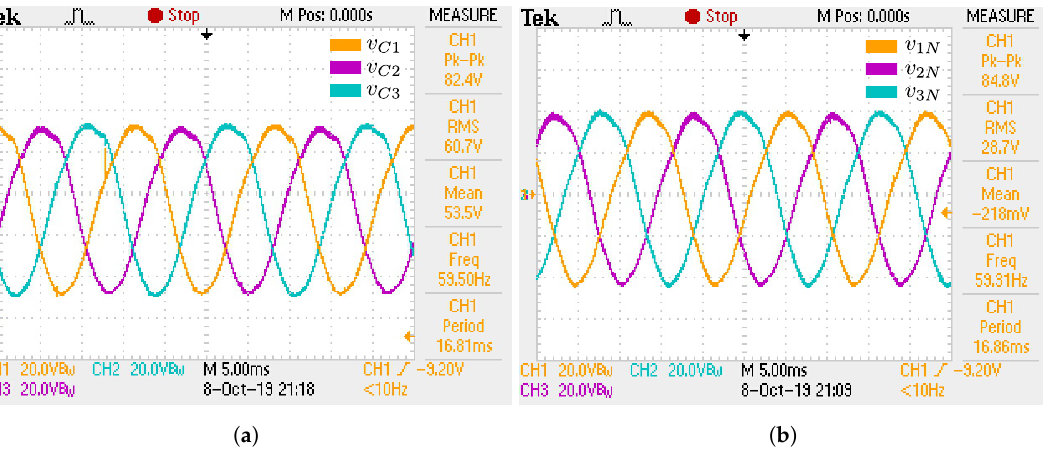
Figure 25. Experimental waveforms of capacitor and load phase voltages for R load case: ( a ) Capacitor voltages; ( b ) Load phase voltages. Table 5. Comparisons between simulated results of single-phase model with experimental results of three-phase model: R